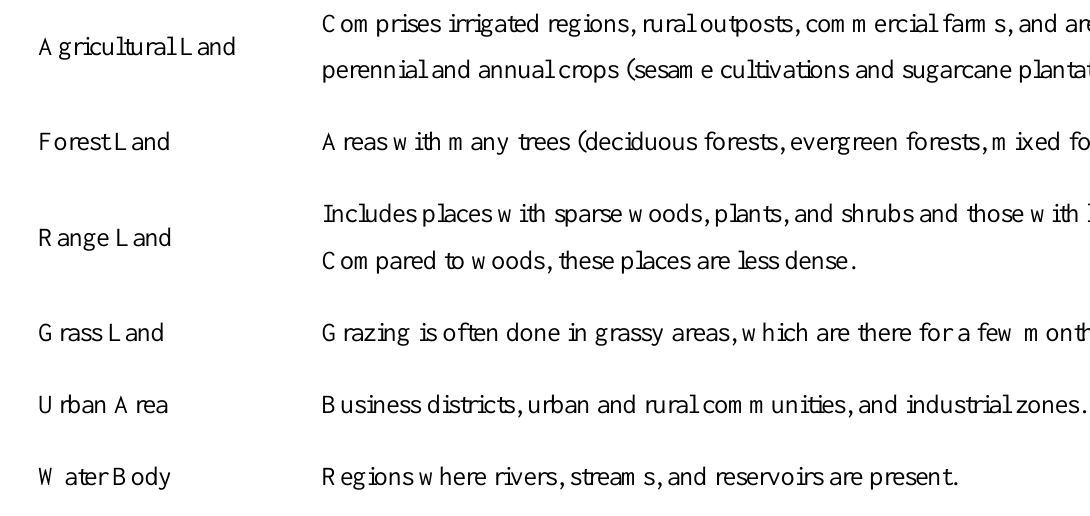
Table 2. The main categories of land cover and their explanations. Comprises irrigated regions, rural outposts, commercial farms, and areas utilised for Agricultural Land perennial and annual crops (sesame cultivations and sugarcane plantations). Forest Land Areas with many trees (deciduous forests, evergreen forests, mixed forests). Includes places with sparse woods, plants, and shrubs and those with little trees. Range Land Compared to woods, these places are less dense. Grass Land Grazing is often done in grassy areas, which are there for a few months of the year. Urban Area Business districts, urban and rural communities, and industrial zones. Water Body Regions where rivers, streams, and reservoirs are